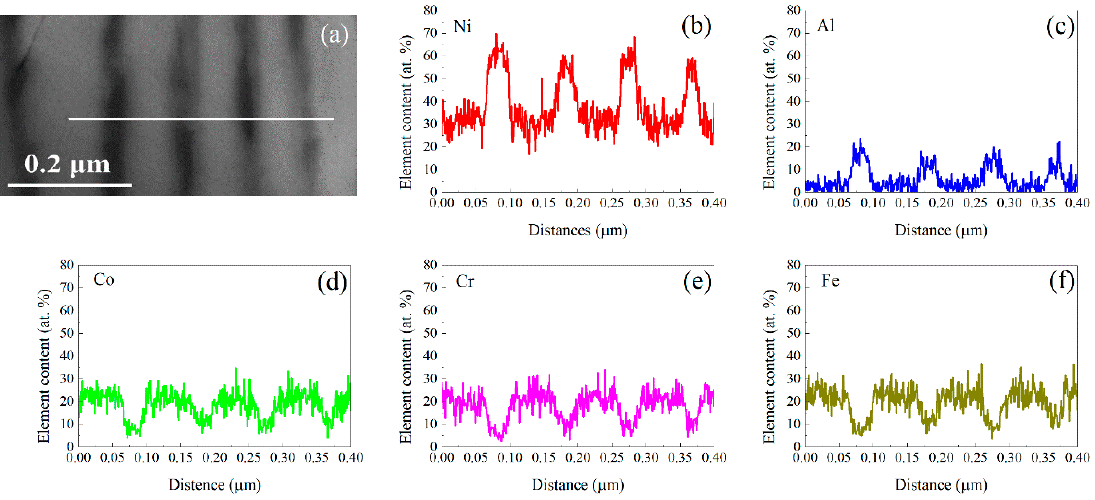
Figure 4. The TEM study of the HEA in STEM mode to illustrate the composition differences between the lamellar grains: ( a ) BF image taken on the lamellae. The concentration line scans by EDS, along the white solid line marked in ( a ), as follows: ( b ) Ni, ( c ) Al, ( d ) Co, ( e ) Cr, and ( f ) Fe. The specimen had the same heat treatment as that in Figure 2.